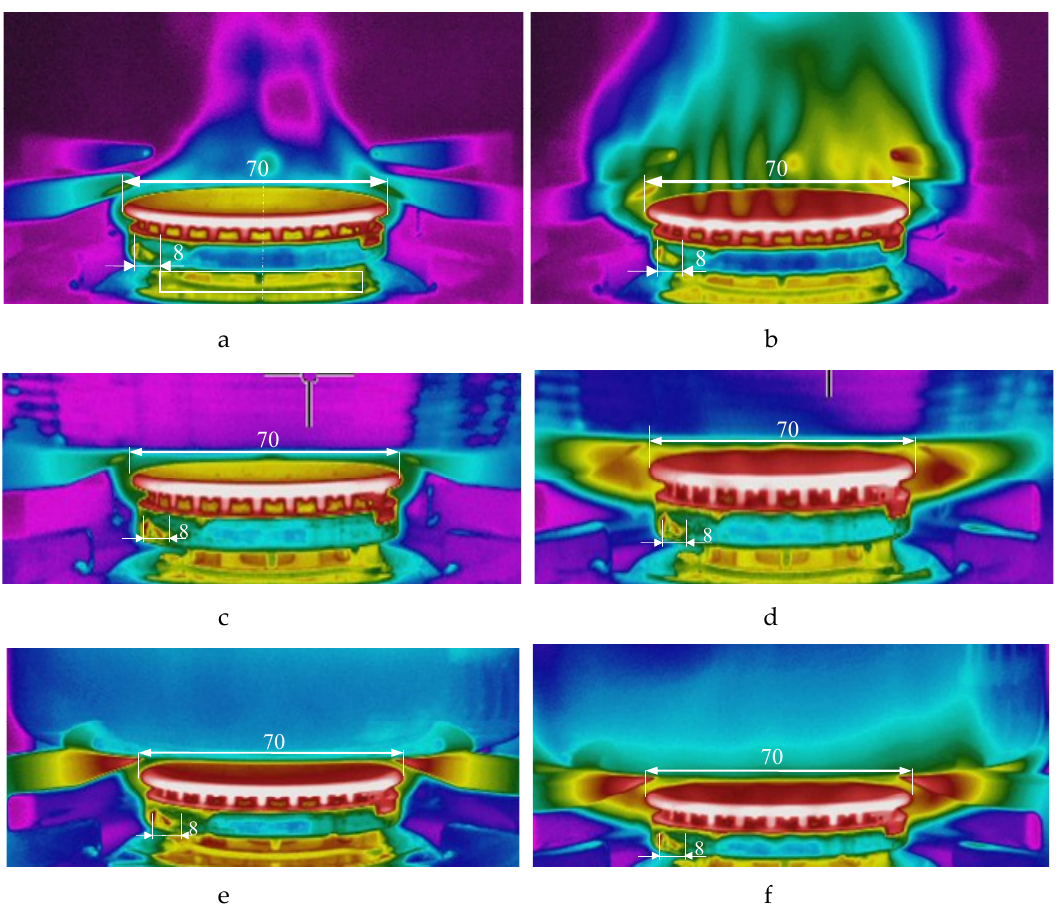
Figure 10. Pictures taken by the infrared camera: ( a ) small flame without a pot, ( b ) big flame without a pot, ( c ) small flame with a pot of 220 mm diameter, ( d ) big flame with a pot of 220 mm diameter, ( e ) small flame with an enameled pot of 170 mm diameter, ( f ) big flame with an enameled pot of 170 mm diameter.